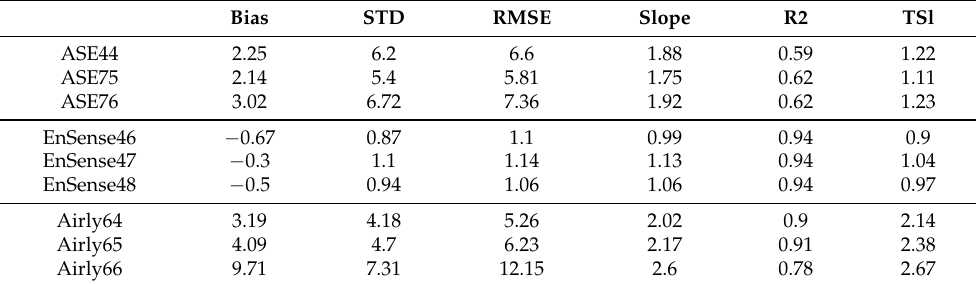
Table 4. Summary statistics of applying the sensor-specific multilinear regression models to the testing period at Kirkeveien. Reference instrument is Fidas and component is PM 1